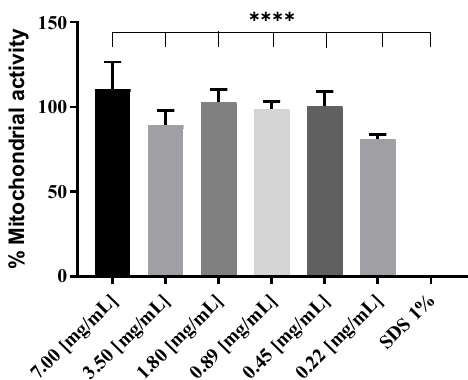
Figure 2. Effect on mitochondrial activity of different concentrations of blank DOTAP 4 liposomes on RAW 264.7 cells after 4 h incubation. Data were normalized to non-treated cell results; SDS served as positive control. Data are presented as mean ± SD ( n = 3). **** indicate p < 0.0001 when comparing SDS 1% group with other groups.